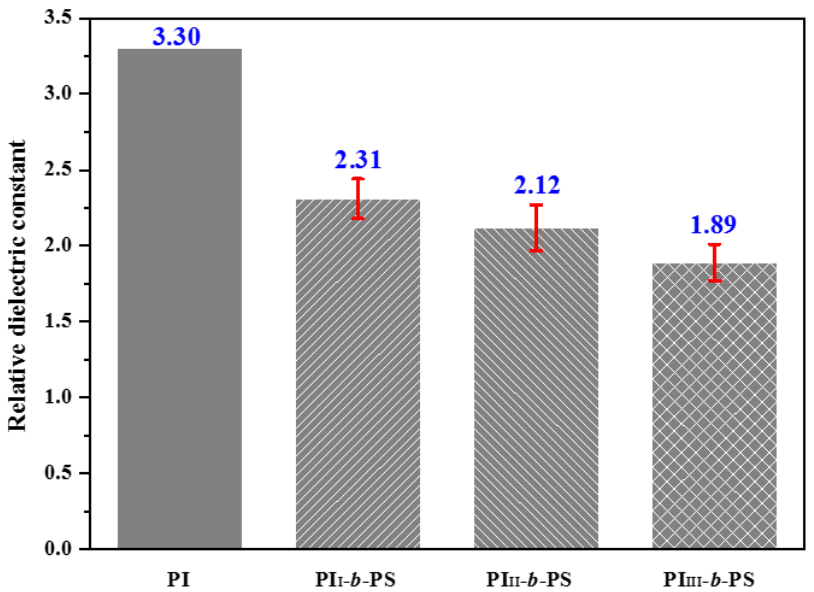
Figure 6. Relative dielectric constants (10 3 Hz) of different PI films calculated by Equation (4). The pure PI film from PMDA and ODA has the relative dielectric constant of 3.30 (10 3 Hz) [24]; when f VPS increases, the relative dielectric constants of obtained PI films from PI- b -PS decrease as 2.31 → 2.12 → 1.89 (Figure 6) owing to increasing porosity (as seen from